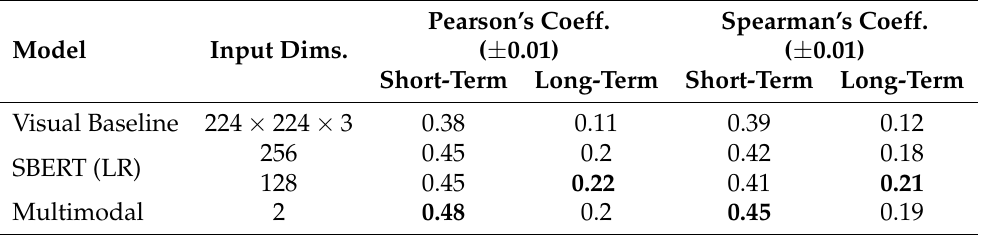
Table 1. Memorability prediction on the VideoMem dataset. Reduced versions of the SBERT text embeddings easily improve upon the visual